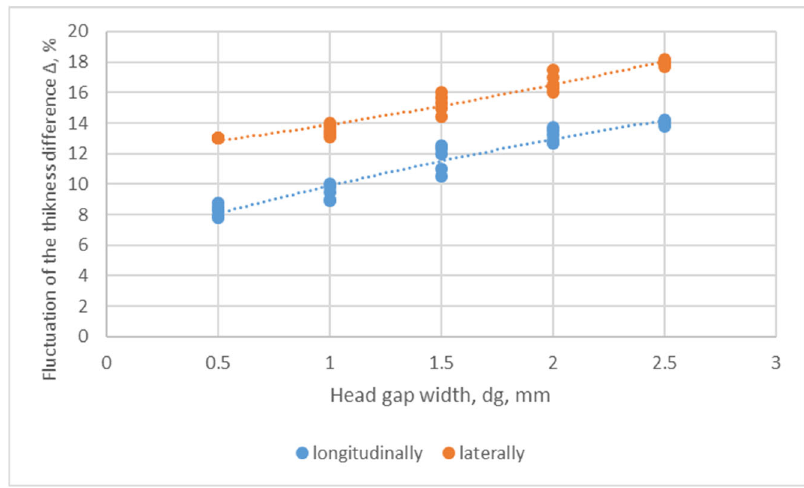
Figure 19. Dependence of fluctuations in the average thickness (thickness difference) of the film on the thickness of the forming slot.